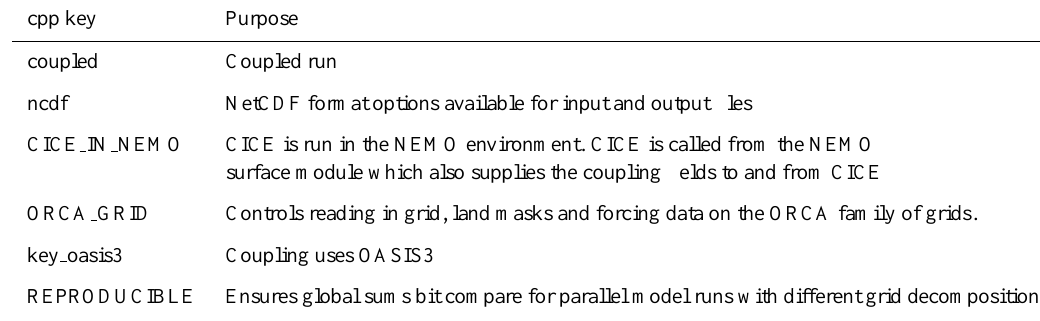
Table D1. The C preprocessor keys used for CICE in HadGEM3r1.1. cpp